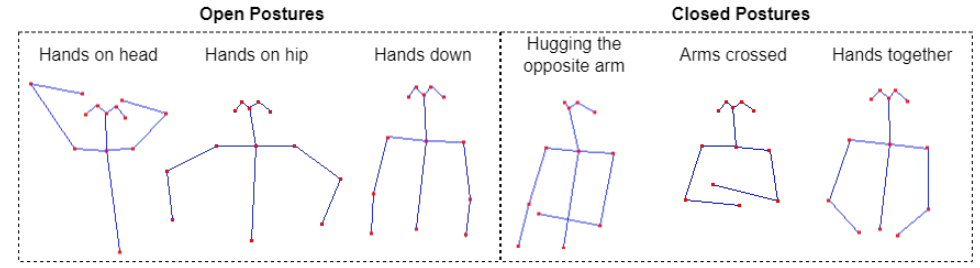
Figure 3. Example postures associated with